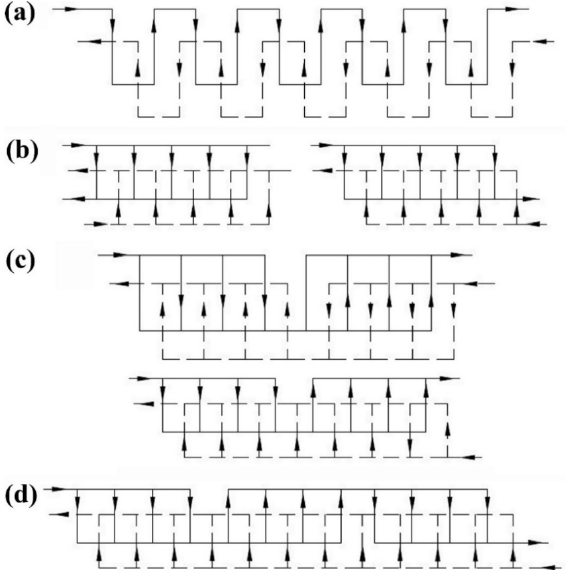
Figure 2. A schematic view of different flow patterns and pass arrangements in plate heat exchangers (PHEs), where ( a ) series flow, ( b ) single ‐ pass looped, ( c ) multi ‐ pass with equal pass, and ( d ) multi ‐ (PHEs), where ( a ) series flow, ( b ) single-pass looped, ( c ) multi-pass with equal pass, and ( d ) multi-pass pass with unequal pass [49]. with unequal pass